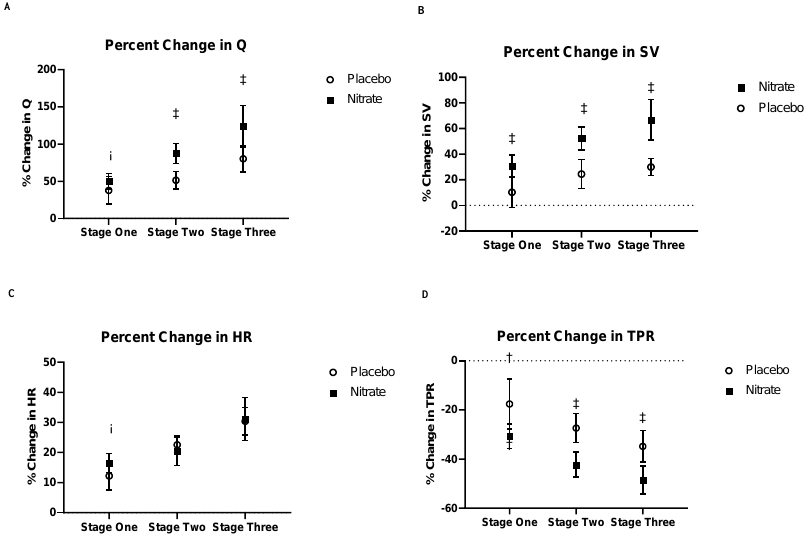
Figure 3. Resting and submaximal exercise responses of ( A ) cardiac output, ( B ) stroke volume, ( C ) heart rate, ( D ) total peripheral resistance. The data represents the percent change of each variable between rest and each exercise intensity.